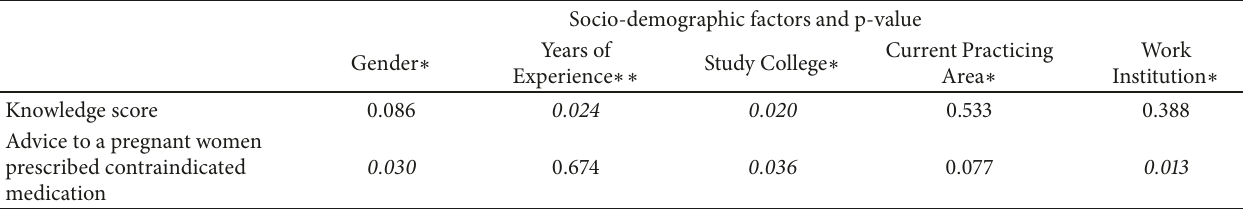
Table 5: Comparison of sociodemographic factors with knowledge score and practice of PPs using nonparametric tests (Kruskal-Wallis and Man-Whitney U test).